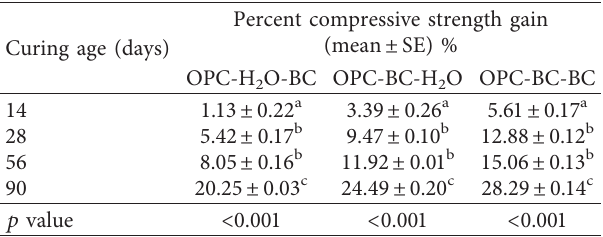
Table 4: Results for Bacillus cohnii percentage gain in compressive strength of mortars.